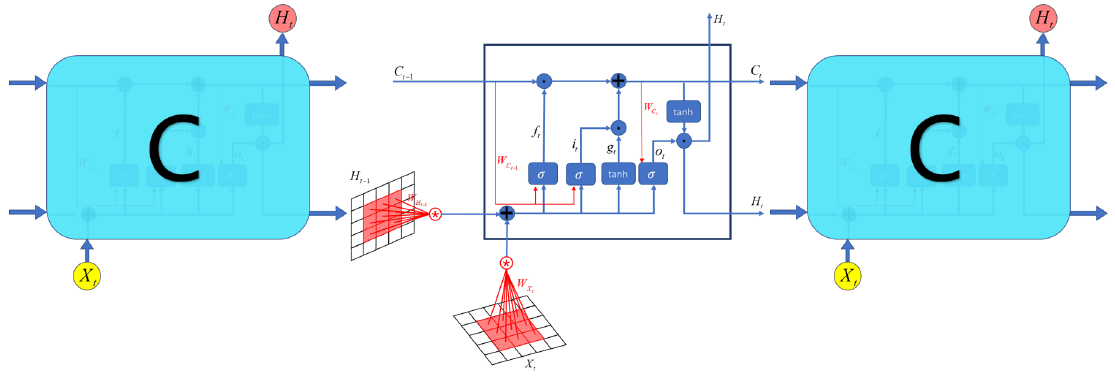
Figure 5. Schematic of the Conv-LSTM’s